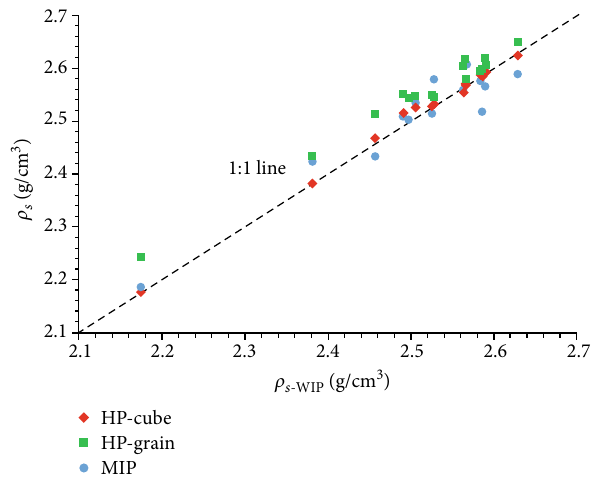
Figure 3: Comparison of skeletal density measured from the HP, WIP, and MIP techniques; the x -axis presents skeletal density from the WIP method and the y -axis from the HP and MIP methods, with smaller values from WIP than from the other methods indicated by the data located above the 1:1 line.